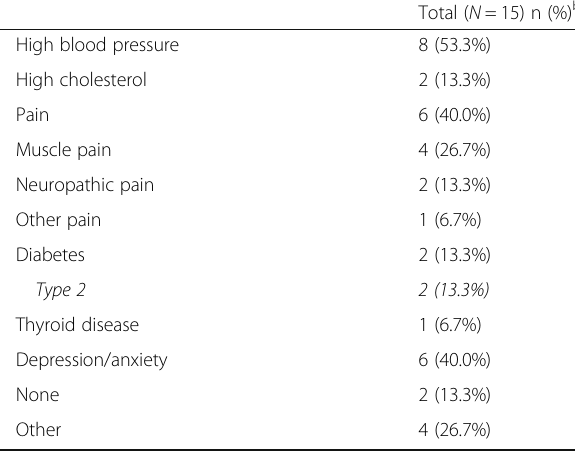
Table 1 Patient interviews: Demographic and health information (self-reported) a